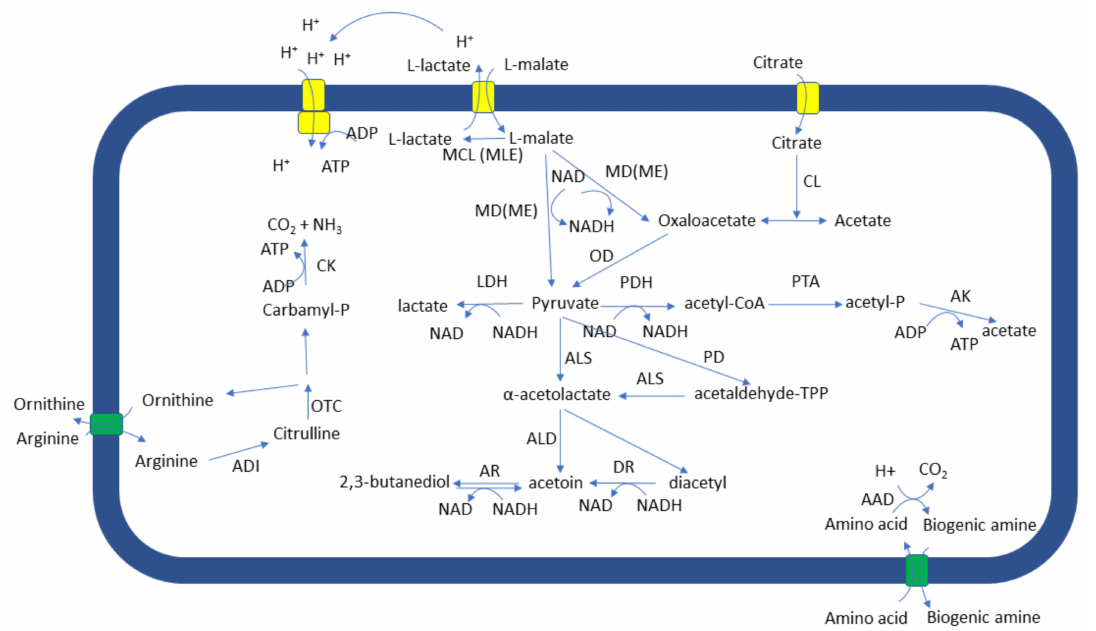
Figure 1. Pathways of malate, citrate, and arginine metabolism as well as formation of biogenic amines by LAB. AAD: amino acid decarboxylase; ADI: arginine deiminase; AK: acetate kinase,